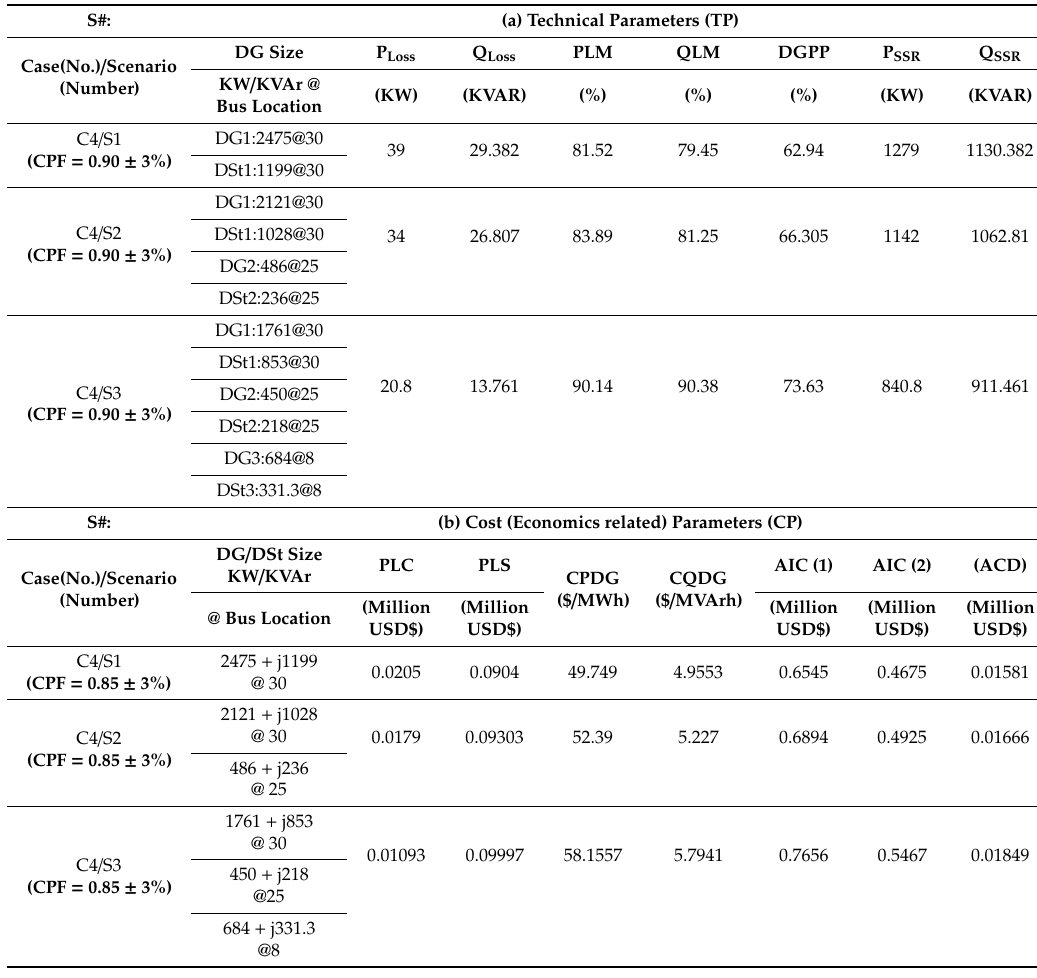
Table 8. (a) Overview of technical performance evaluation analysis in case 4 (33-bus). (b) Overview of Cost-Economics performance evaluation analysis in case 4